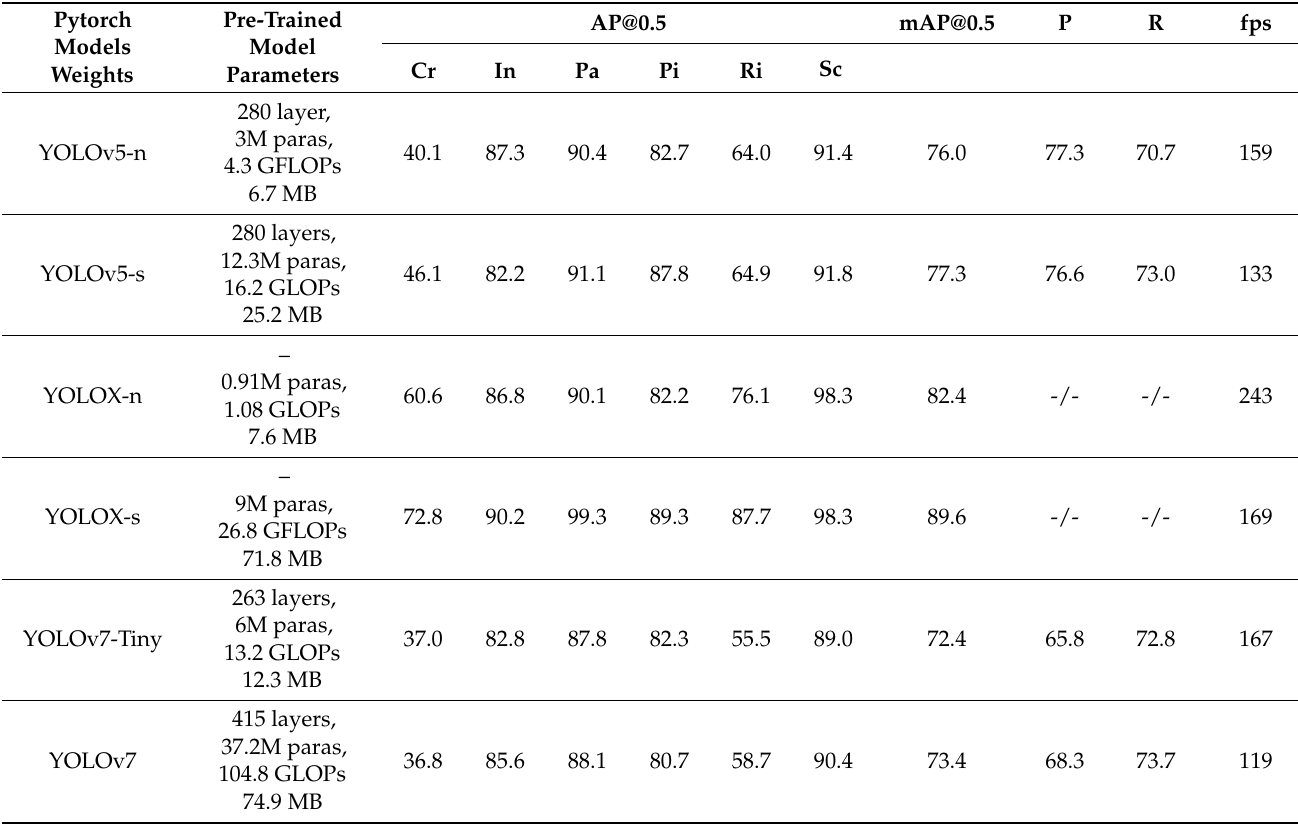
Table 5. Performance of six models on NEU-DET validation set on RTX